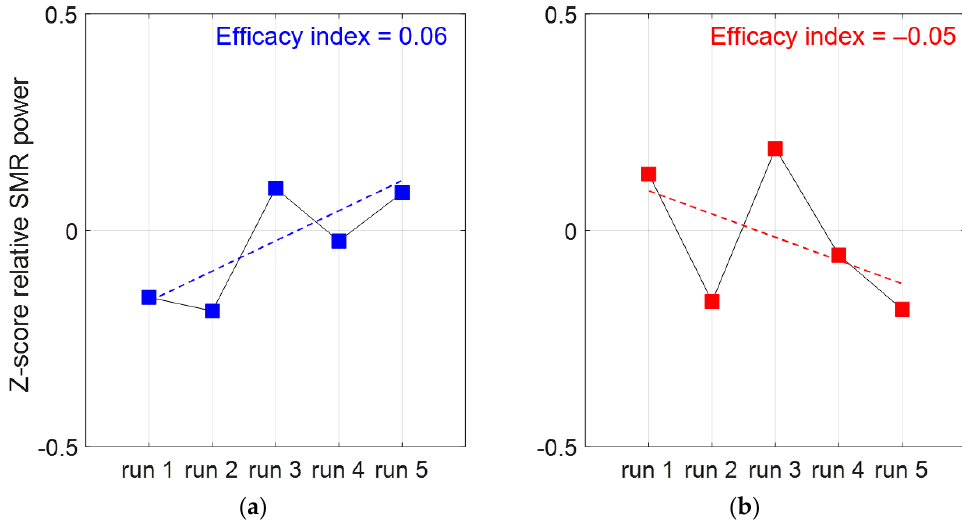
Figure 4. Two examples of individual efficacy quantification where linear fits of SMR relative power as a function of the five successive NFb runs show better efficacy in participant ( a ) when compared to participant ( b ).